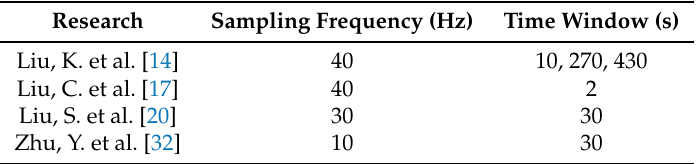
Table 5. Sampling frequency and time window chosen in